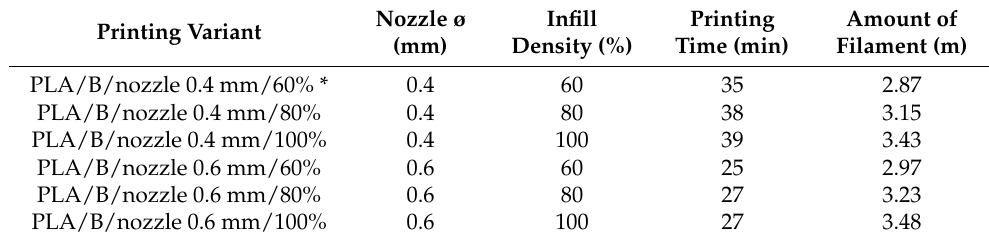
Table 1. Parameters for the printing